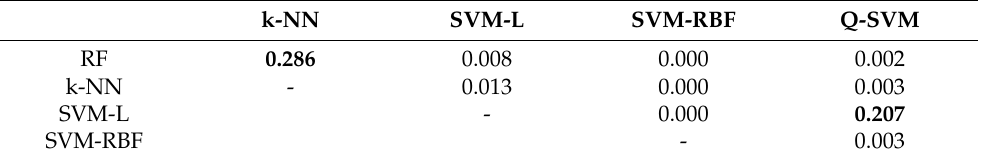
Table 9. p -value for each pair of models using 19 latent space AE. k-NN